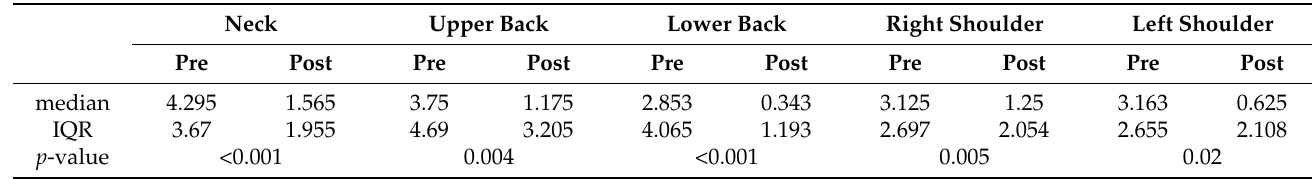
Table 2. Descriptive data of the pain intensity at baseline and post-intervention in the neck, upper back, lower back and right and left shoulders.